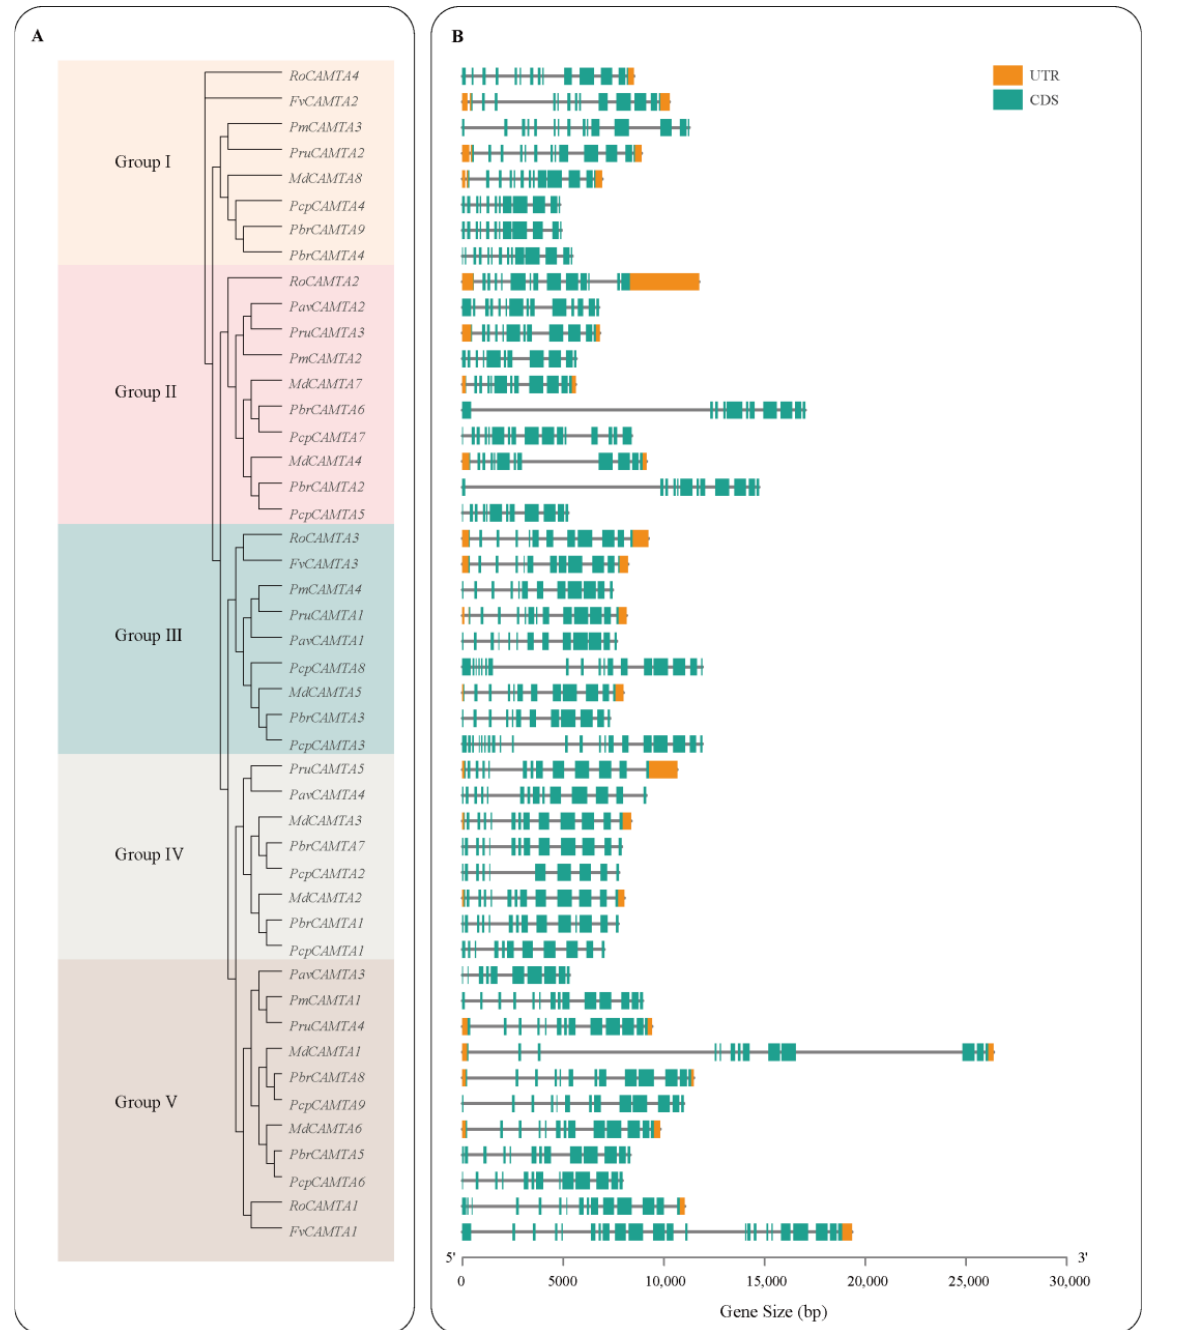
Figure 3. Phylogenetic relationship and gene structure of the CAMTA gene family in eight Rosaceae species. ( A ) The phylogenetic tree is constructed by iqtree using the neighbor-joining (NJ) method with 1000 bootstraps. ( B ) Intron – exon structures of CAMTA genes in eight species.